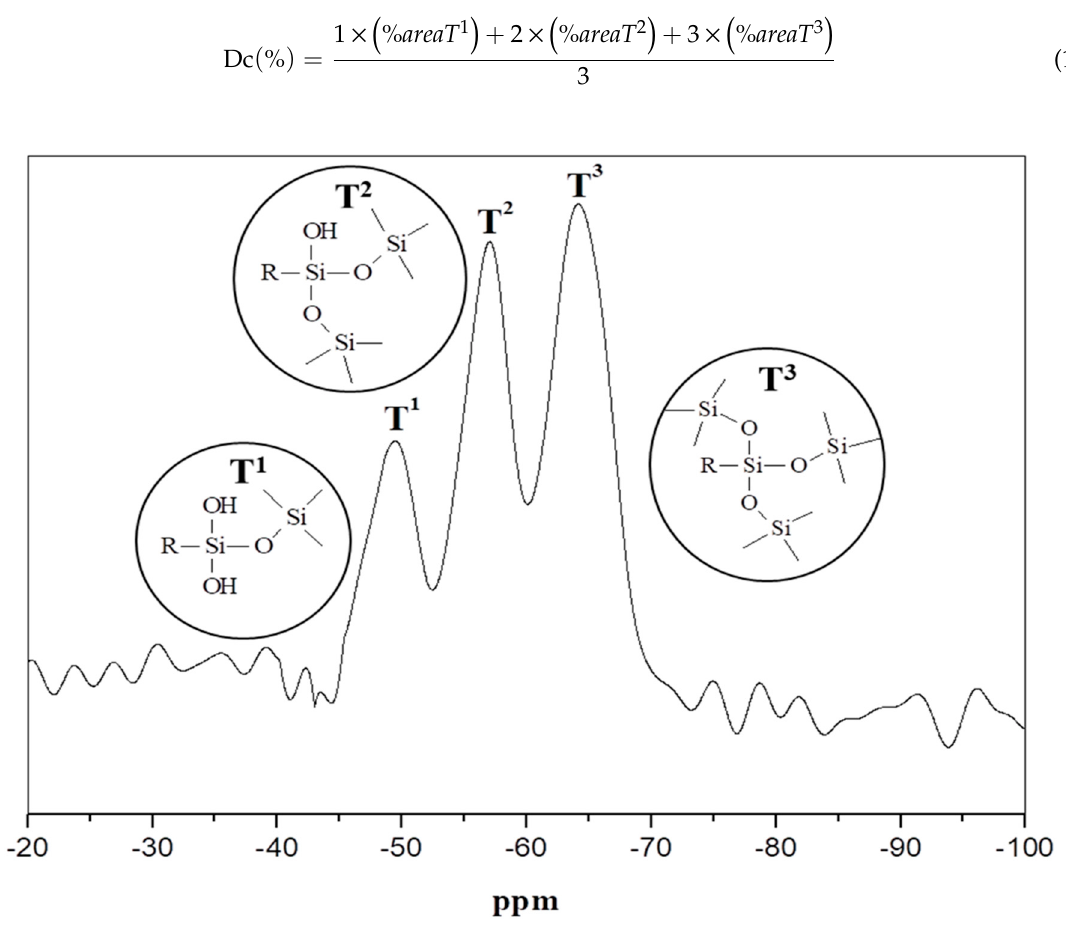
Figure 5. Solid-state 29 Si NMR spectra of Si-PU/APTS-GPTS. Table 1. Distribution of area proportion.